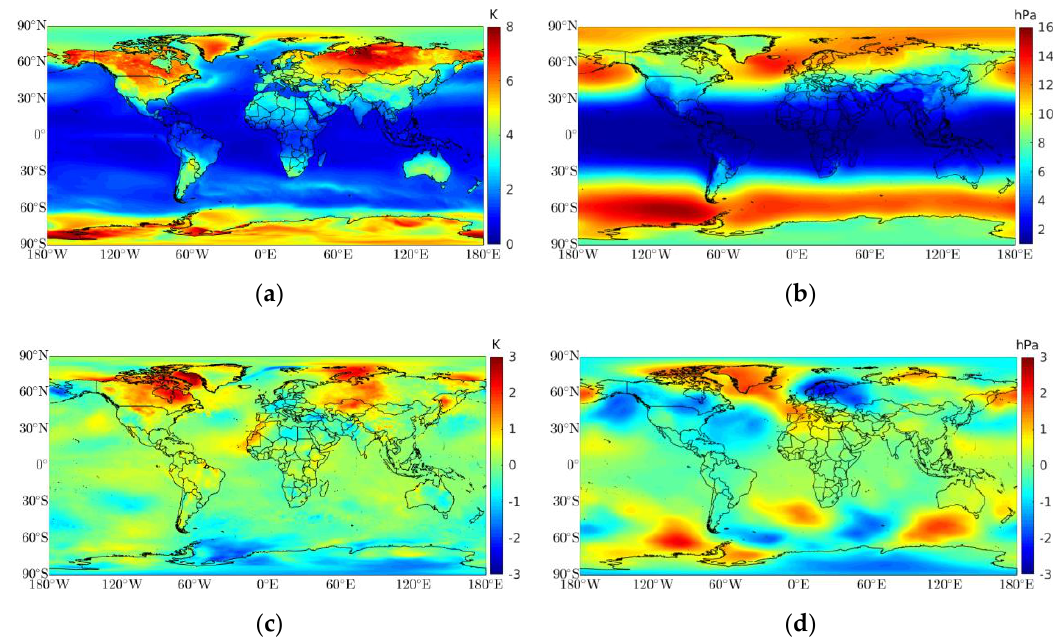
Figure 7. Comparison of 20 years of ERA5 surface air temperature and pressure with the modeled values using Equations (1) and (2): ( a ) mean RMSE for surface air temperature (K), ( b ) mean RMSE for surface pressure (hPa), ( c ) mean bias for surface air temperature (K), and ( d ) mean bias for surface pressure (hPa). Note that a positive bias value indicates an hourly global pressure and temperature (HGPT) model overestimation and a negative bias value indicates an underestimation.